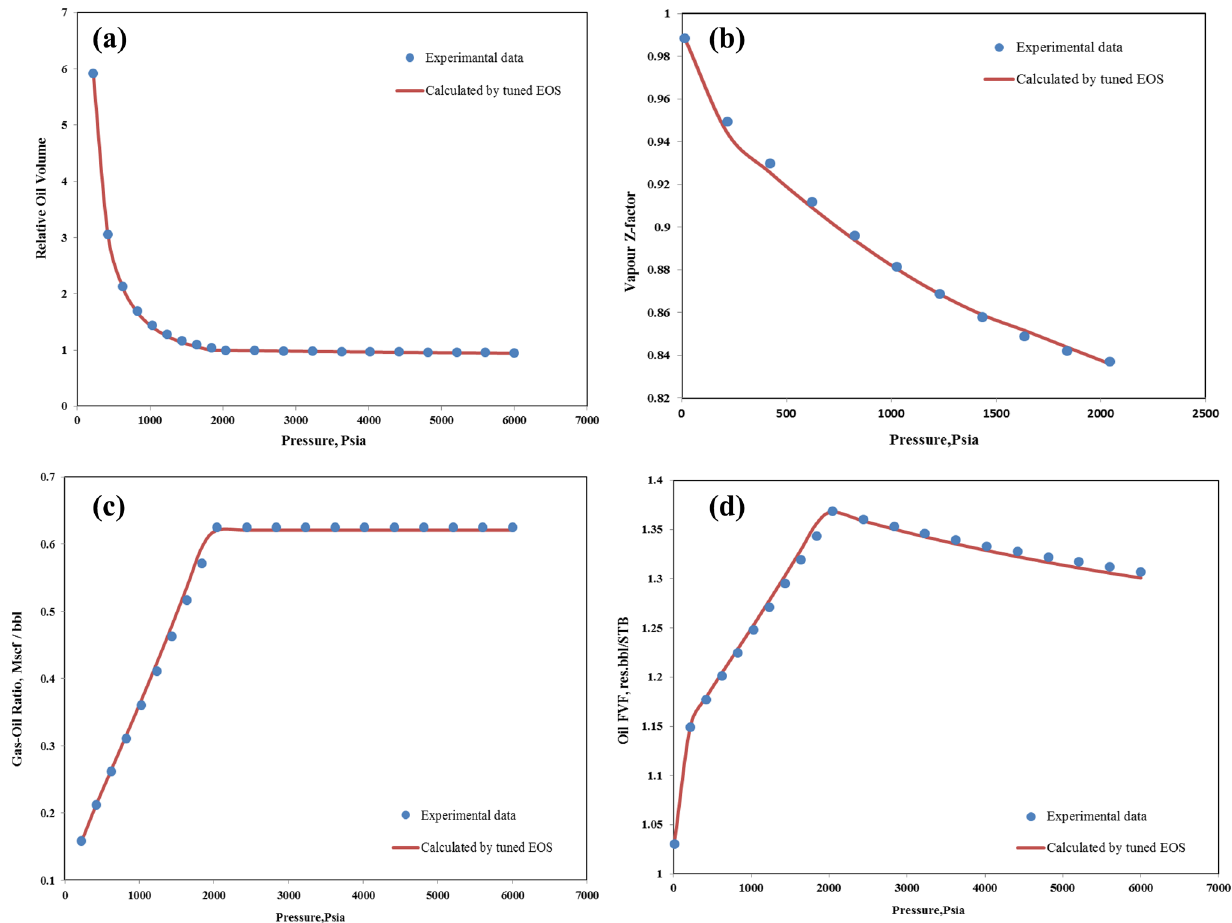
Fig. 1 Comparison of experimental and calculated PVT data, a relative volume (CCE test), b vapour z -factor (DL test), c gas/oil ratio (DL test), d oil formation volume factor (DL